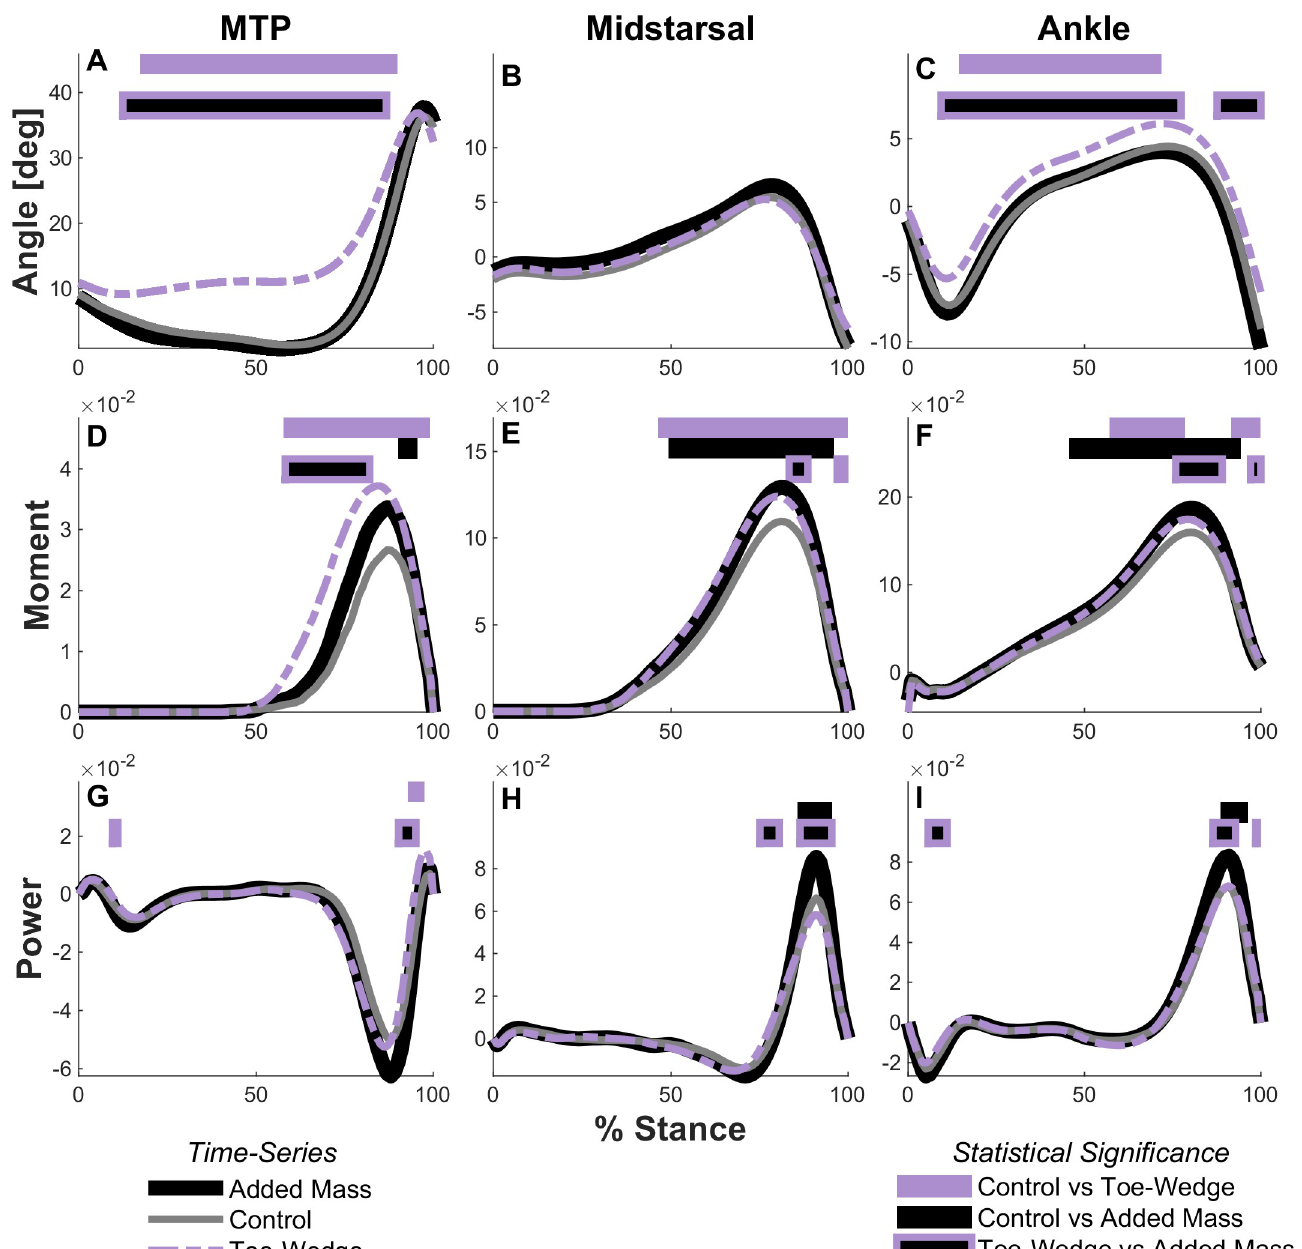
Fig 3. Joint angles, resultant moments, and six degrees of freedom powers. Time-series profiles of sagittal plane MTP, midtarsal, and ankle joint angles (panels A-C), resultant joint moments (panels D-F), and six degrees of freedom joint powers (panels G-I) in the added mass, control, and toe-wedge conditions. Moment and power are expressed as dimensionless quantities. Horizontal bars across the top of each panel indicate timings of statistically significant time-series differences between conditions using two-tailed paired t-tests ( α = 0.017 after Bonferroni correction). https://doi.org/10.1371/journal.pone.0274141.g003 (p = 0.0084), greater positive ankle joint work (p < 0.001), and greater magnitude of distal foot negative work (p = 0.0238) when walking with added mass compared with the control condi- tion (Fig 5B and S2 Table). Midtarsal joint quasi-stiffness increased from the control condition to the added mass condition (p < 0.001; Fig 6B).